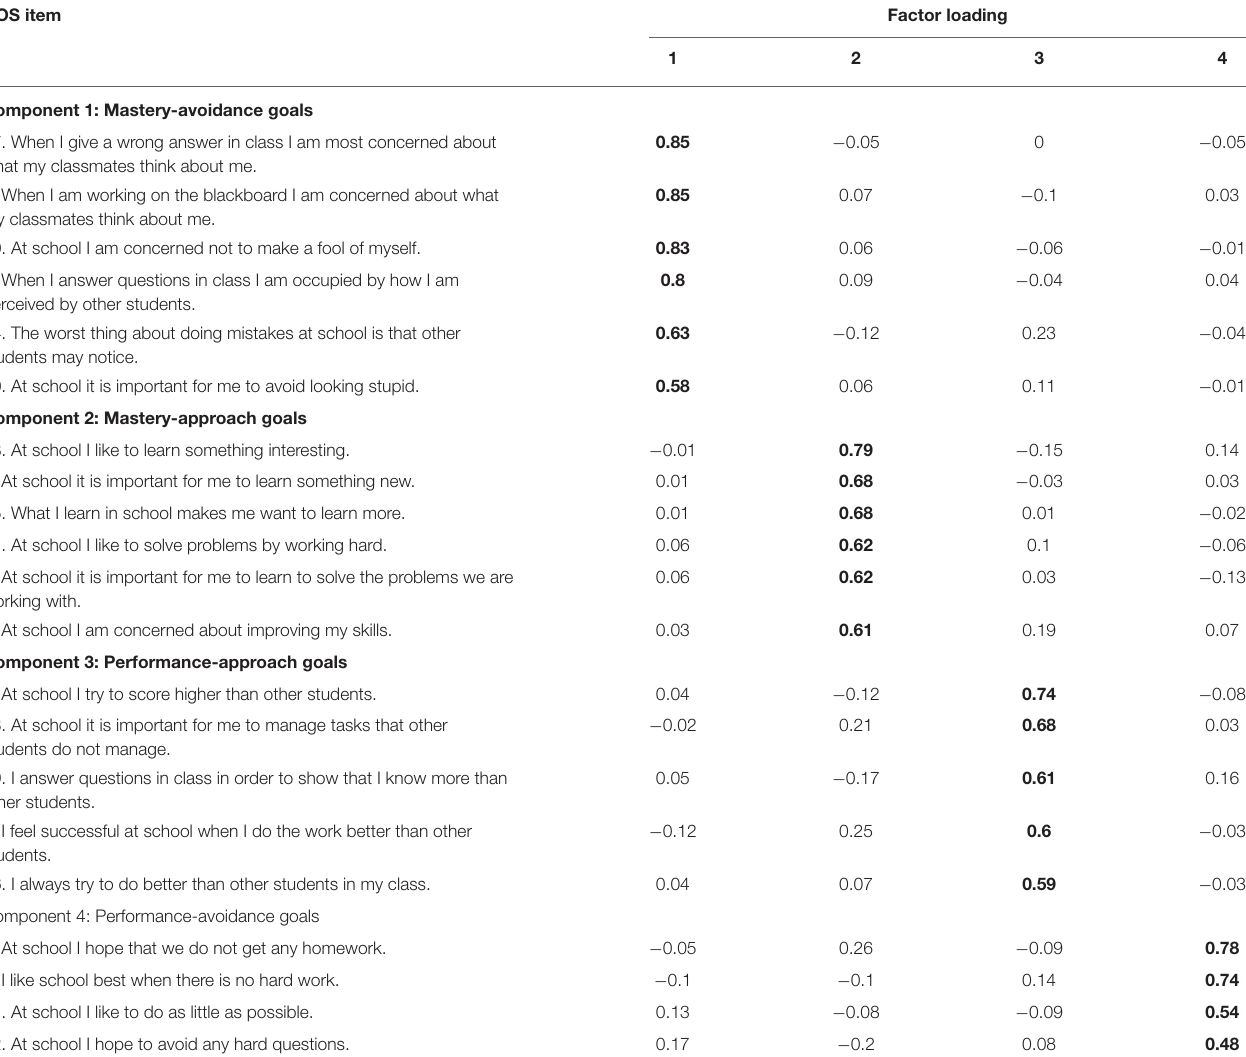
TABLE 2 | Results from a principal component analysis of the Goal Orientation